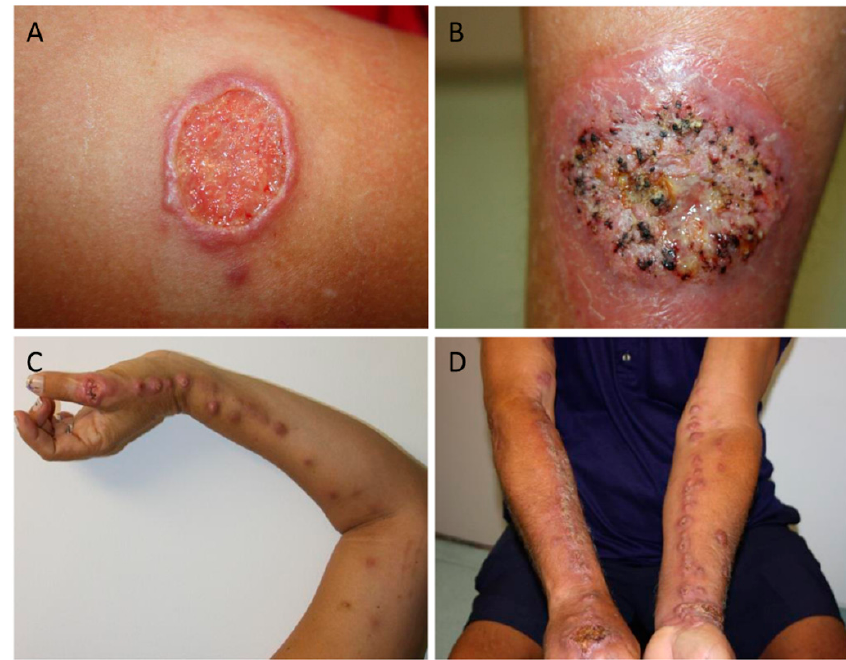
Figure 1. The clinical presentations of patients with the ( A , B ) fixed form of sporotrichosis, and ( C , D ) lymphocutaneous form of sporotrichosis as described in Table 1. Pictures were kindly provided by